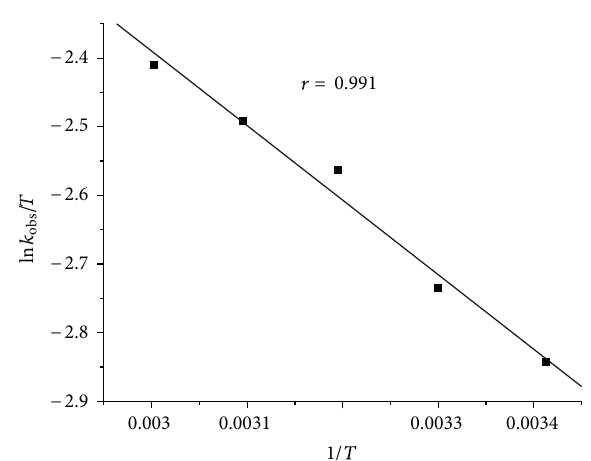
F 4: Plot of perature on reaction rate.